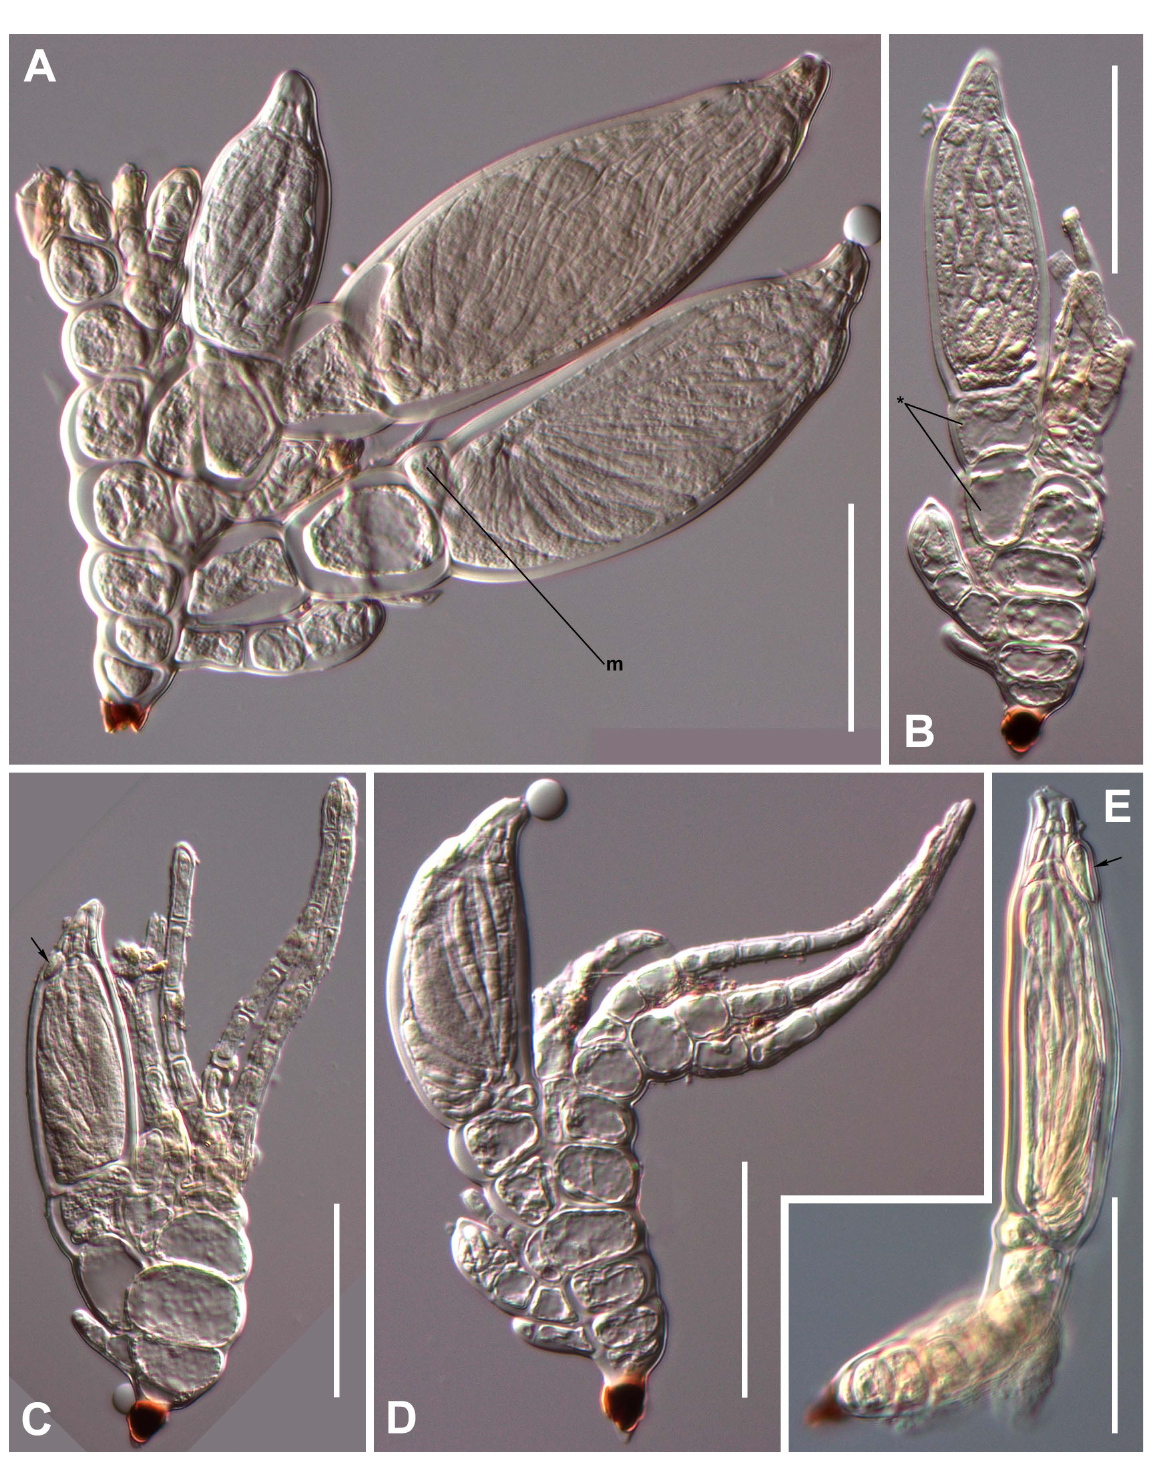
Fig. 19. Asaphomyces cholevae Thaxt. A – E . Mature thalli with labelled cell m in A, cells VI and VI′ (*) in B, and enlarged w (arrows) in C and E. Thallus in E is from the holotype. Scale bars: 50 µm. 3 Photographs from slides ZMUC C-F-122758 (A), ZMUC C-F-122527 (B–C), ZMUC C-F-122654 (D), FH3980